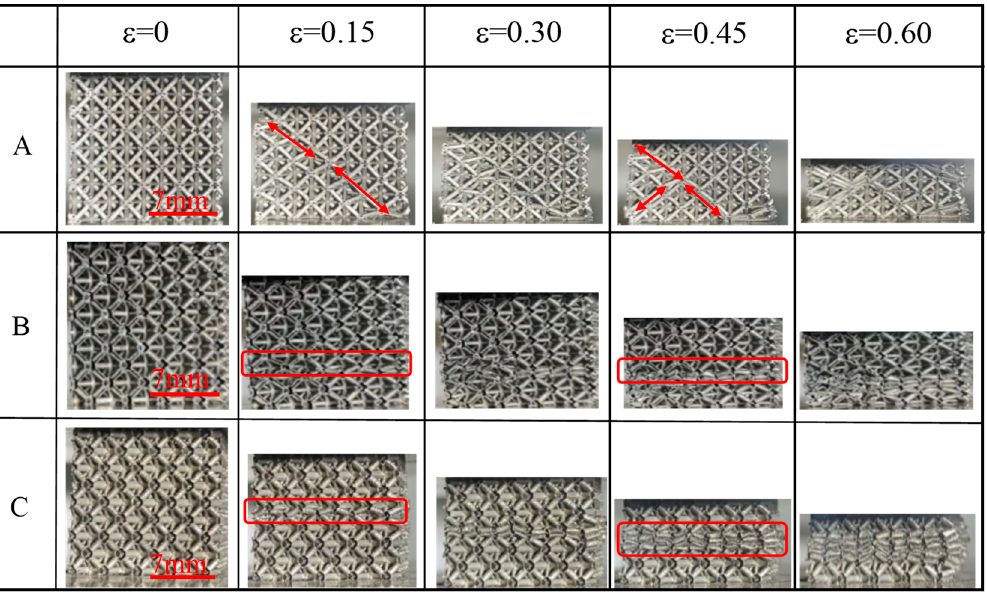
Figure 6. Quasi-static compression deformation process of the lattice with different rod diameters of the same length.